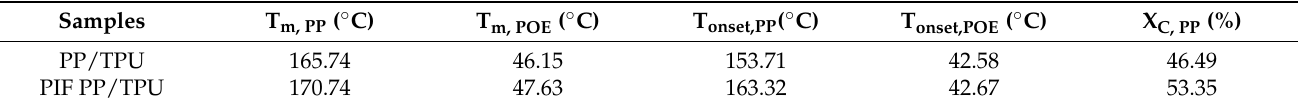
Table 3. Thermal properties of PP/POE blends before and after PIF .